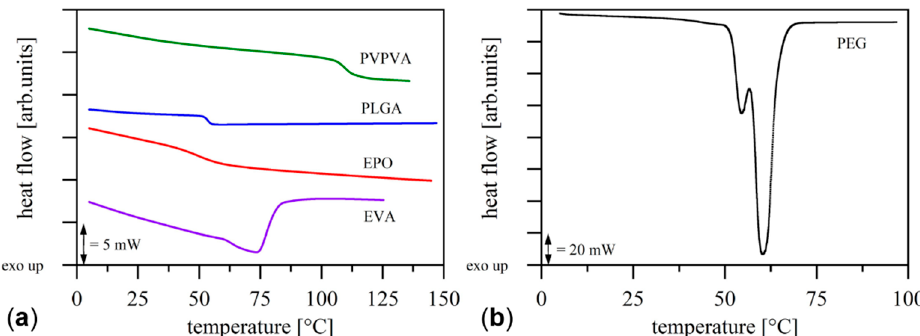
Figure 2. Representative second heating ramps of the differential scanning calorimetry measurements with the amorphous ( a ) and crystalline ( b ) materials in powder form.